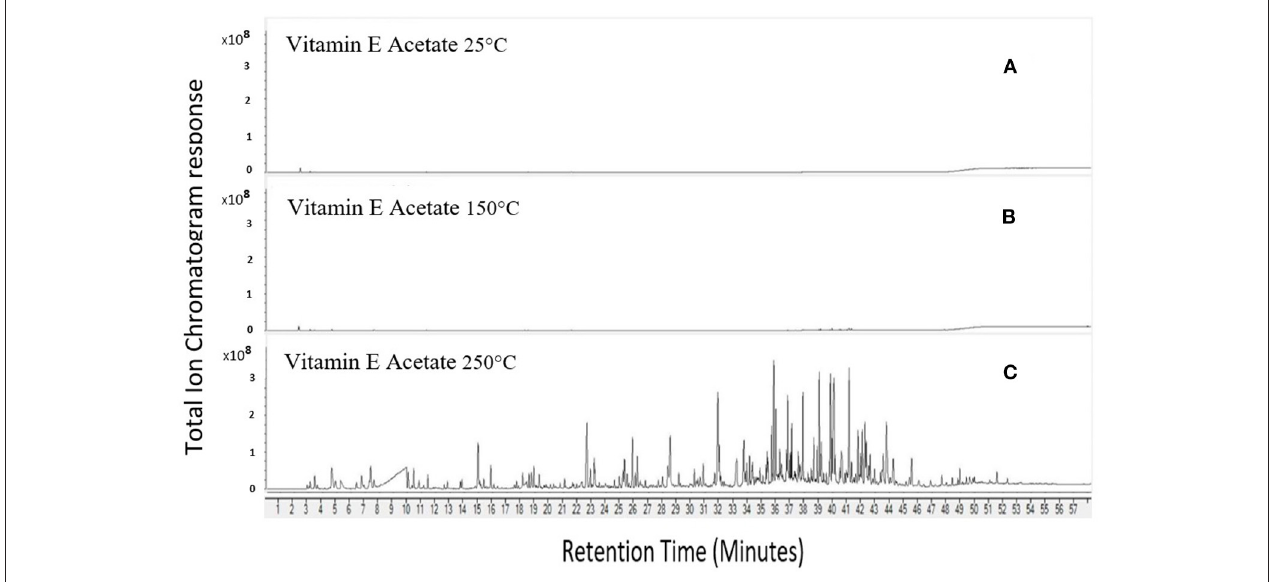
FIGURE 5 | Increasing emissions from VEA with increasing temperature. 25 ◦ C (A) , 150 ◦ C (B) , 250 ◦ C (C)